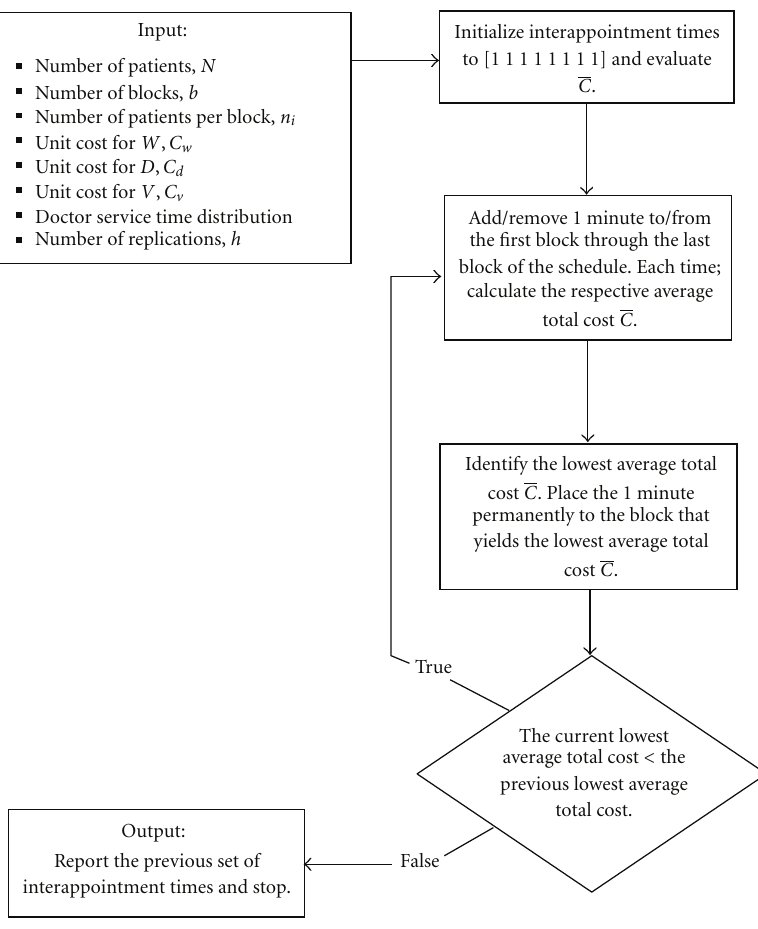
Figure 2: Flowchart of simulation-based heuristic